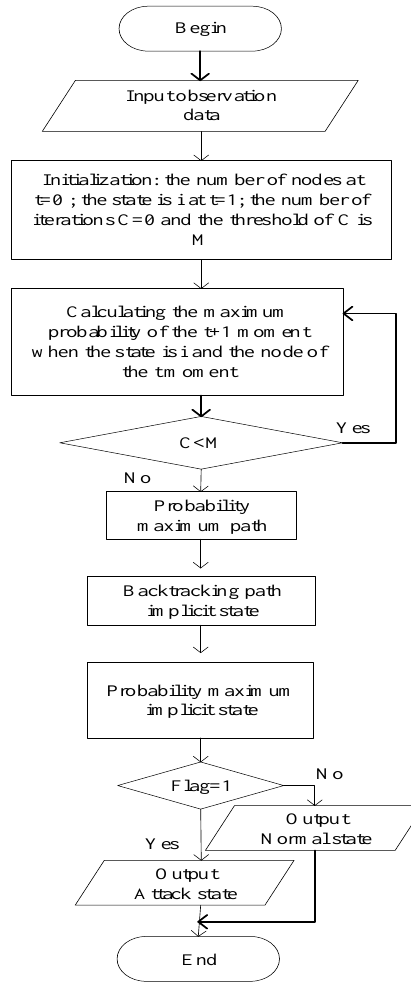
Figure 4. Viterbi algorithm process.